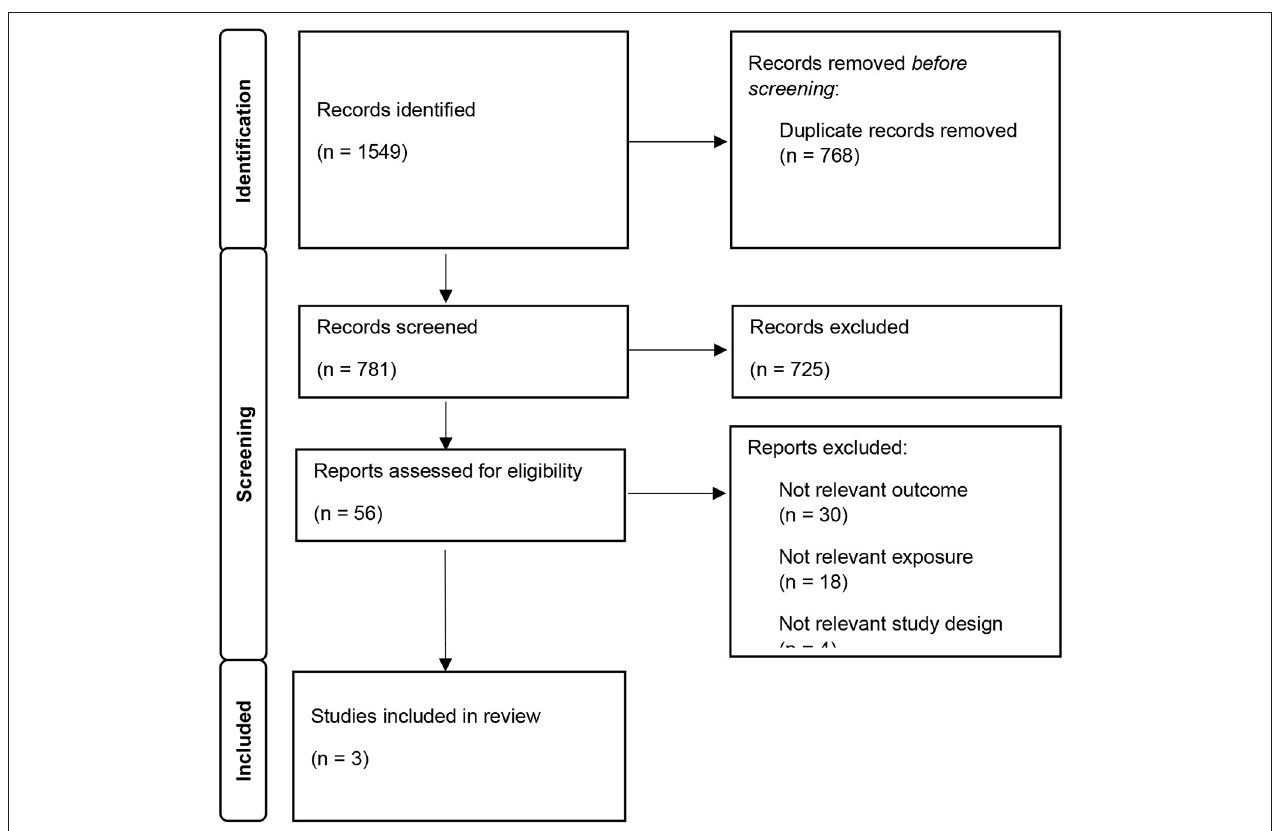
FIGURE 1 | Prisma 2020 study screening flow chart and reasons for full-text screening study